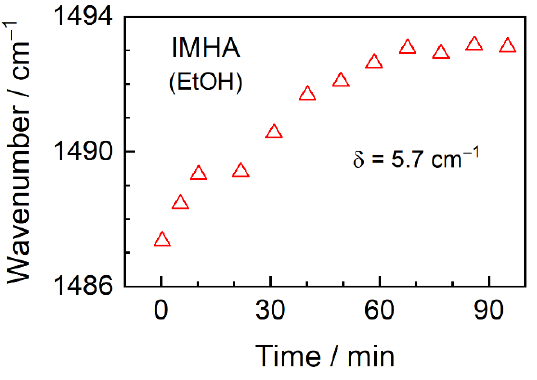
Figure 5. Dependency of the ν (C2–N3) + β (C2H) vibration frequency of the imidazole ring on the SAM formation time.